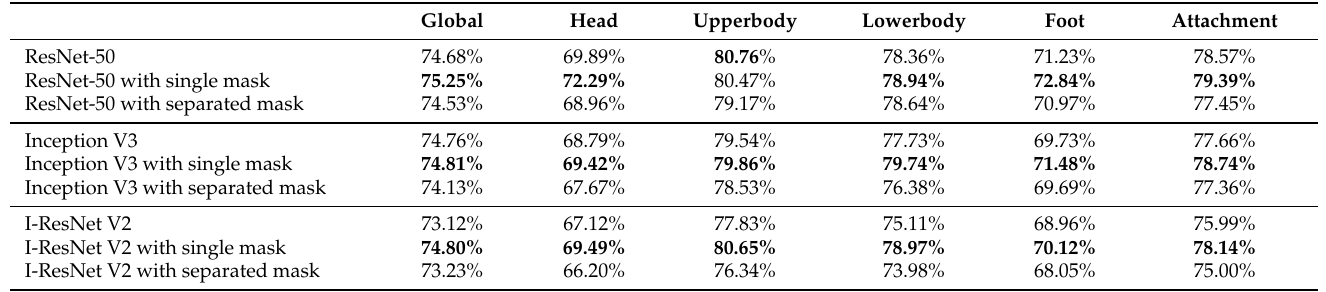
Table 7. The attribute classification performance in mA from PETA